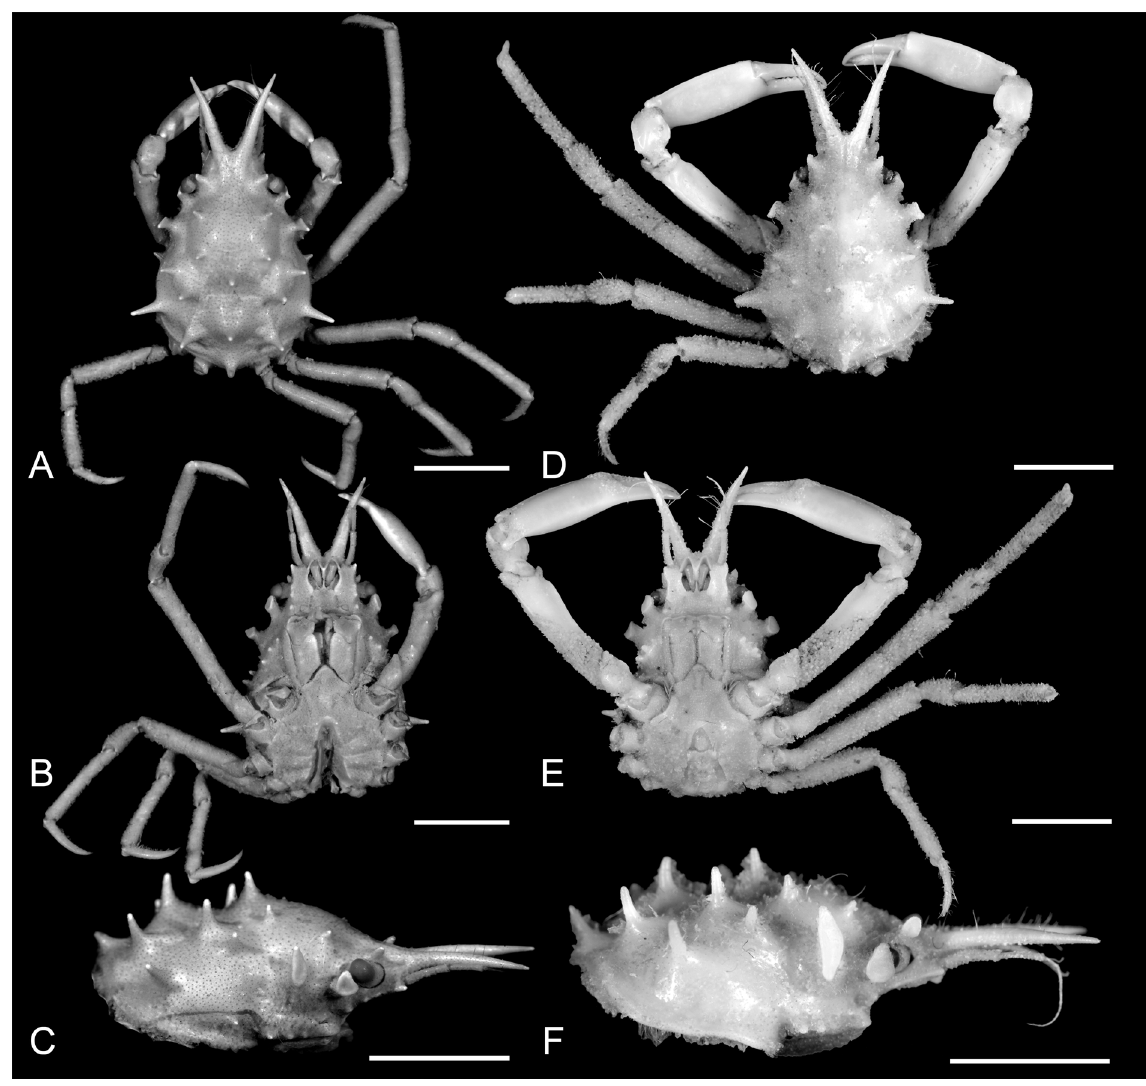
Fig. 9. Rochinia strangeri Serène & Lohavanijaya, 1973. A–C . Holotype, ♂ (10.7 × 7.2 mm) (USNM149304), South China Sea. A . Overall dorsal view. B . Overall ventral view. C . Lateral view of carapace. D–F . ♂ (12.1 × 8.0 mm) (ZRC 2016.0546), South China Sea. D . Overall dorsal view. E . Overall ventral view. F . Lateral view of carapace. Scale bars = 5